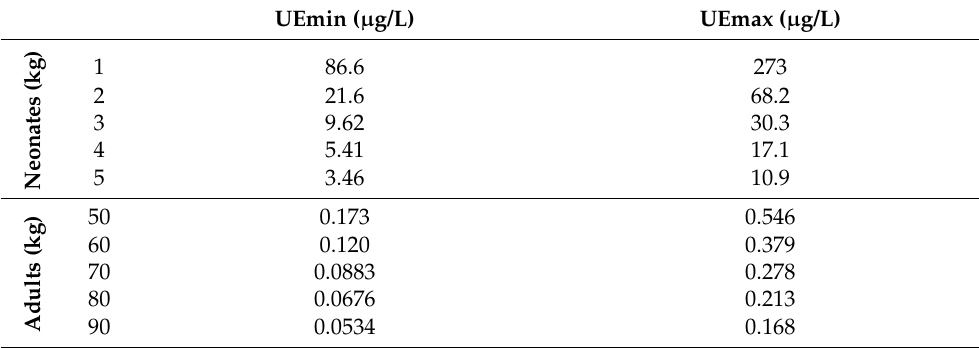
Table 2. Estimation of the urinary mono-(2-ethylhexyl) phthalate (MEHP) concentrations in neonate and adult groups (in µ g/L) using di-(2-ethylhexyl) phthalate (DEHP) levels obtained for Sample